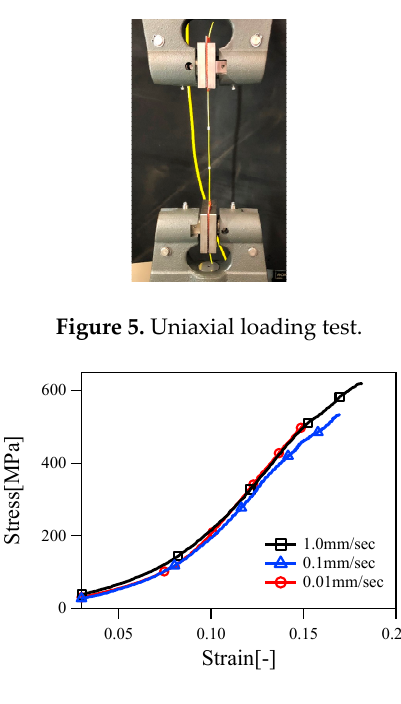
Figure 6. Stress-strain relationships of the nylon